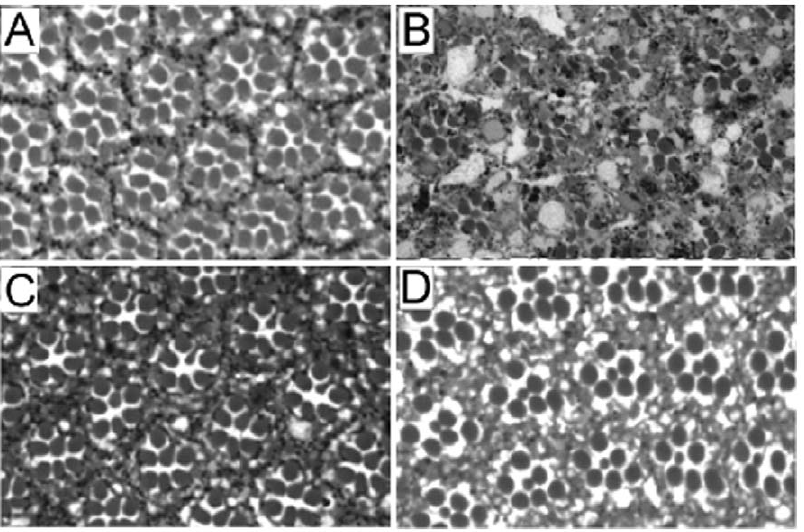
Figure 2. GGA P1 does not cause age-dependent retinal degeneration. Wild type ( A ), ey/GMR-Gal4 . ; dGGA RNAi2 ( B ), GGA P1 ; Dp(1;3)DC203 ;( C ) and w 1118 ; Dp(1;3)DC203 ( D ) adult flies were aged 14 d. at 25 u C, and the eyes sectioned, stained with toluidine blue and examined by light microscopy. Ommatidial organization and rhabdomere number/morphology are normal in panels A , C and D , but highly degenerated in panel B . Note the small number of pigment granules in the w 1118 ; Dp(1;3)DC203 eyes reflects the weak white transgene expression in this stock relative to the wild-type white gene expression in the Oregon R and GGA P1 ; Dp(1;3)DC203 stocks.